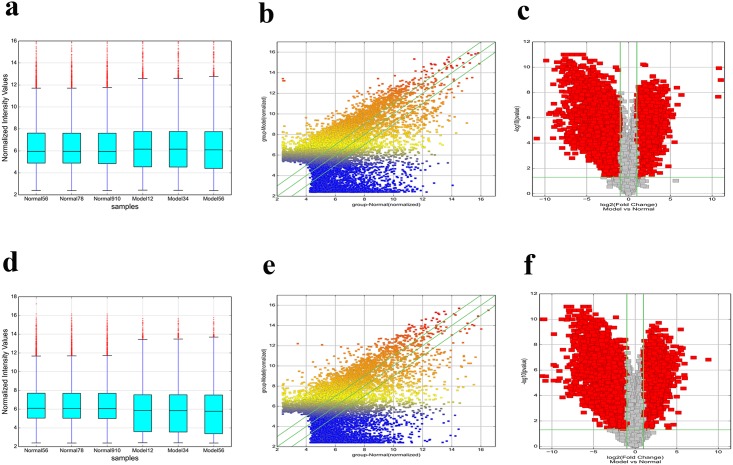
Plots of lncRNA and mRNA.Box plot of (A) lncRNA and (D) mRNA. Scatter plot of (B) lncRNA and (E) mRNA. Volcano plot of (C) lncRNA and (F) mRNA. Plots were constructed using fold-change and p values, enabling visualization of the relationship between fold change (magnitude of change) and statistical significance (which takes both magnitude of change and variability into consideration). The vertical lines correspond to a 2-fold change in expression (up or down), and the horizontal line represents p = 0.05. The red point in the plot represents the differentially expressed genes with statistical significance.